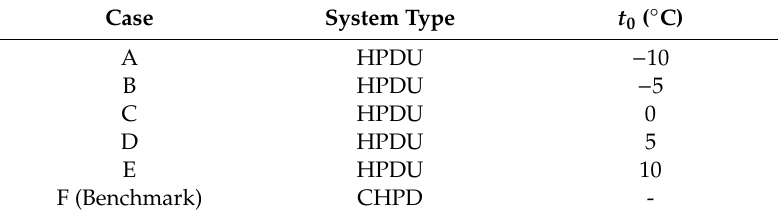
Table 2. Summary of the numerical cases.